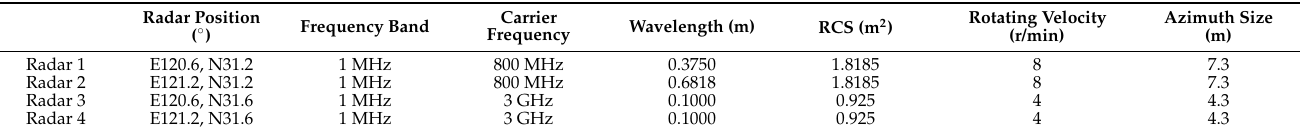
Table 7. Radar network parameters (four radars).